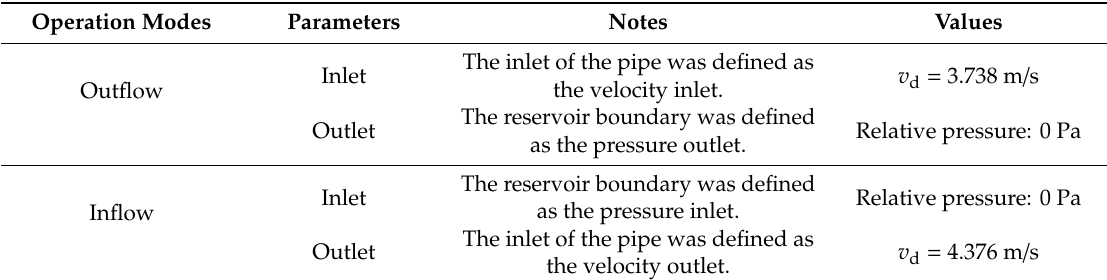
Table 2. Boundary conditions applied in the inlet/outlet CFD simulation.